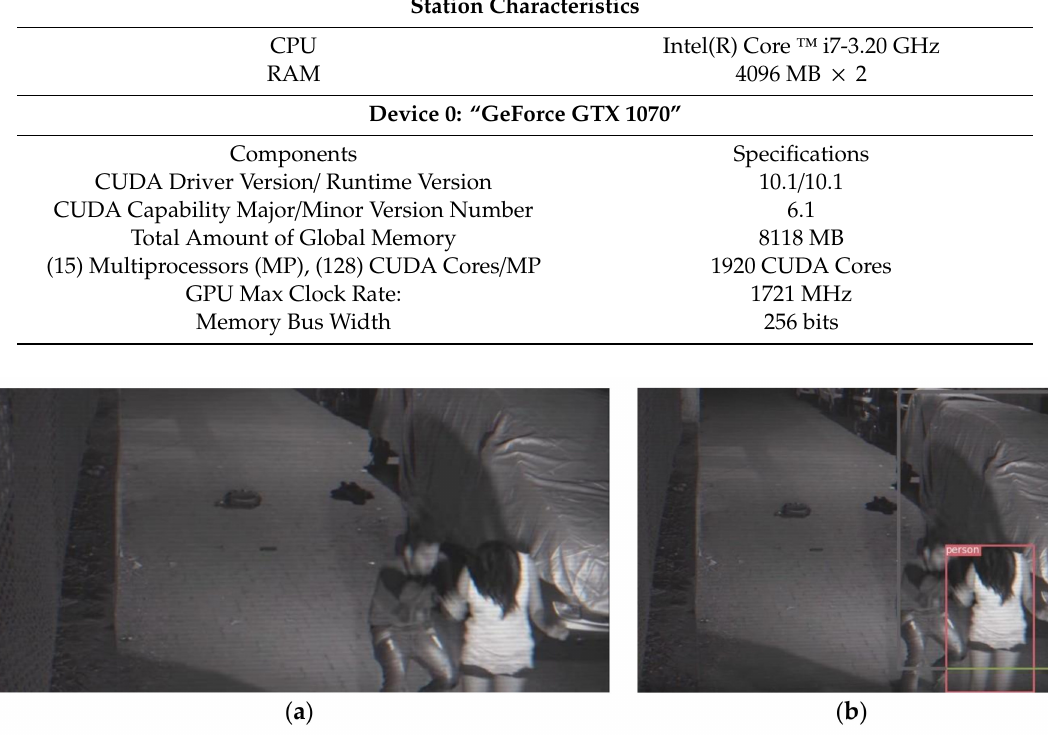
Figure 7. YouTube video containing a sexual assault attempt [46]. ( a ) We can see the victim being assault by an individual. ( b ) Our system performs an analysis of the scene, extracts the zone of interest and returns the response (triggering the alert or not).